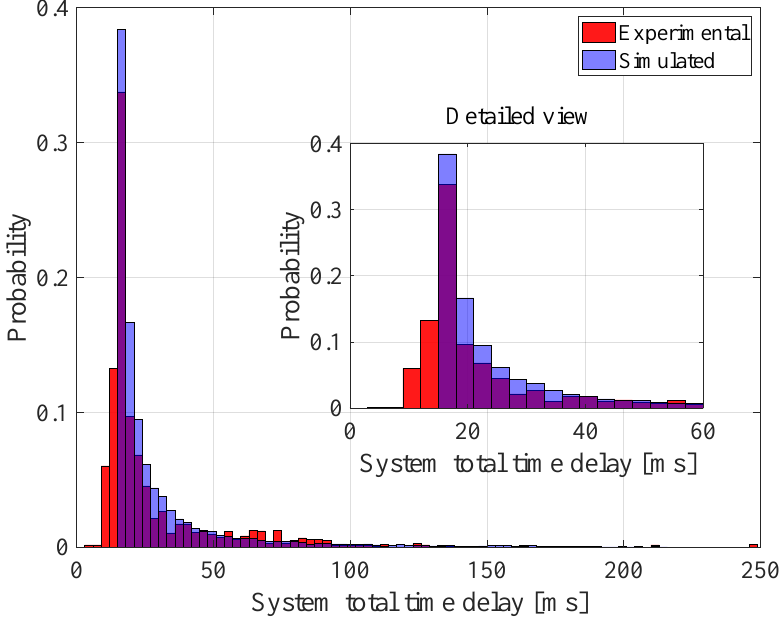
Figure 5. Histogram of command transmission delay. Delay was measured between the controller output and the arrival at the micro-controller